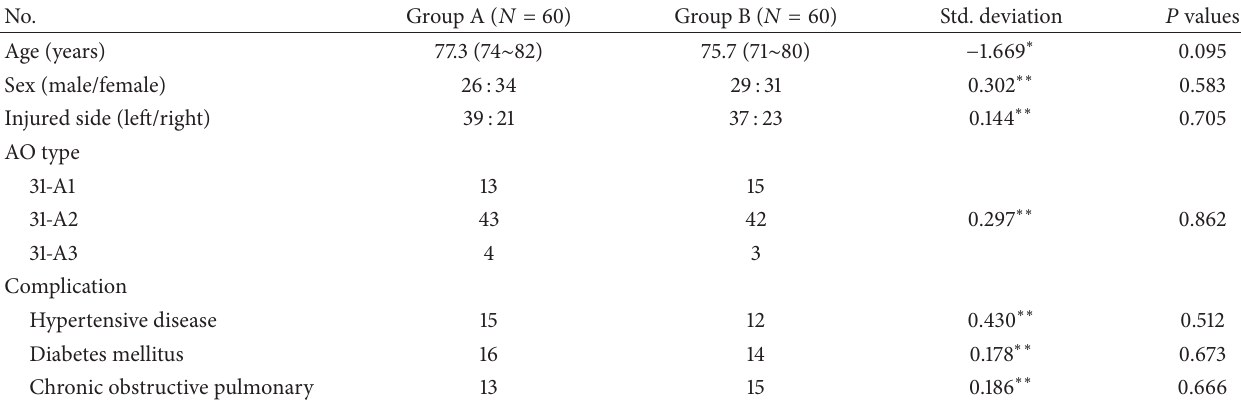
Table 1: Baseline characteristics in the lateral decubitus position and supine position groups.